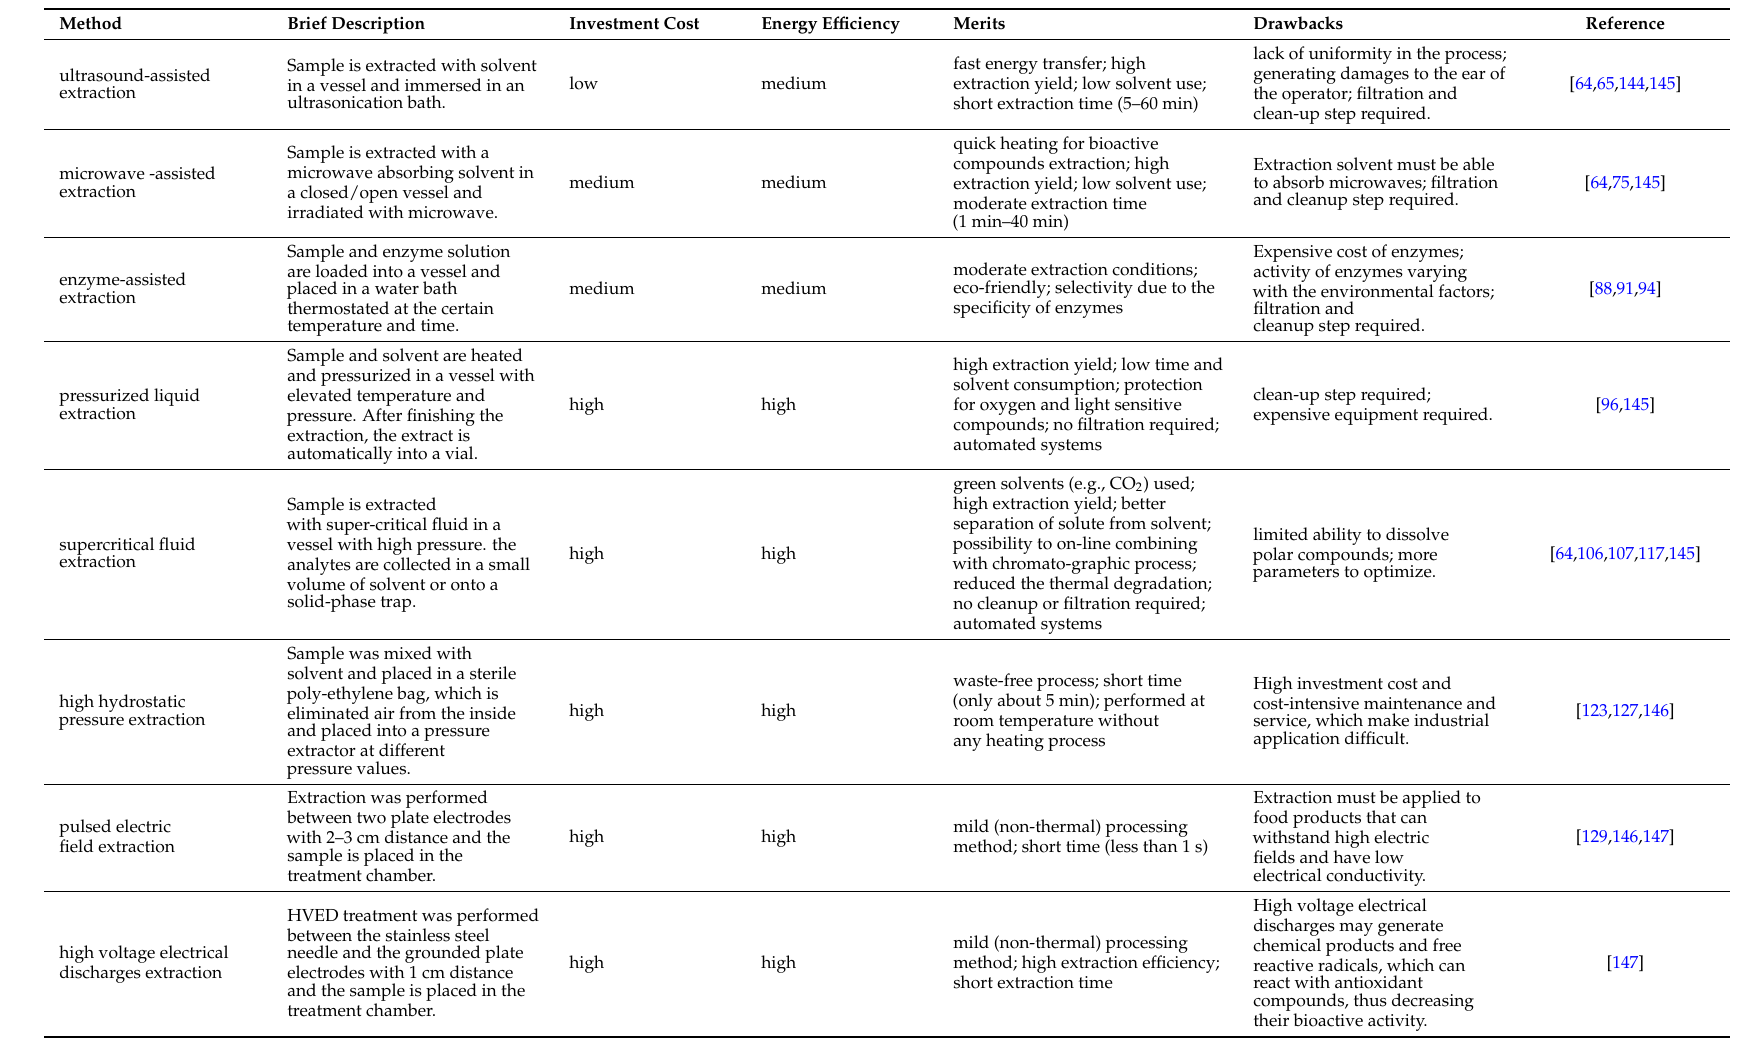
Table 2. Comparison of non-conventional extraction